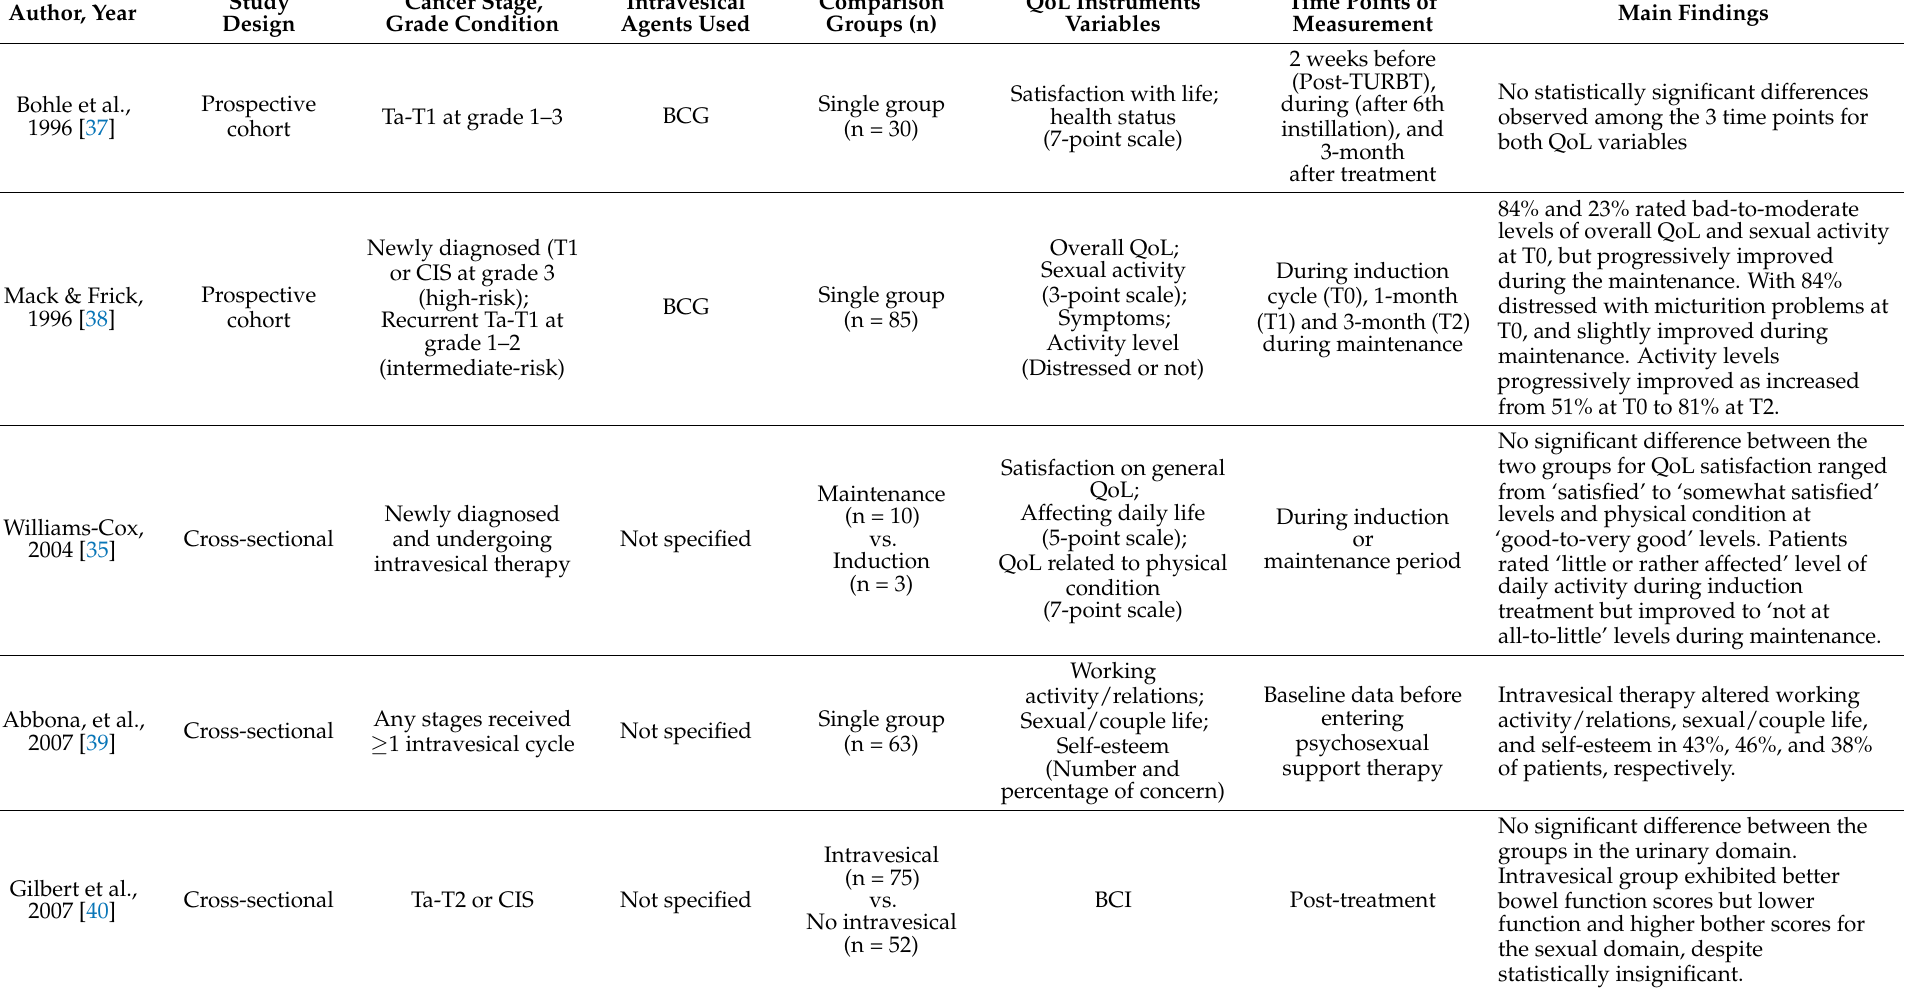
Table 1. A summary of the characteristics and main findings of the eligible studies included in this systematic